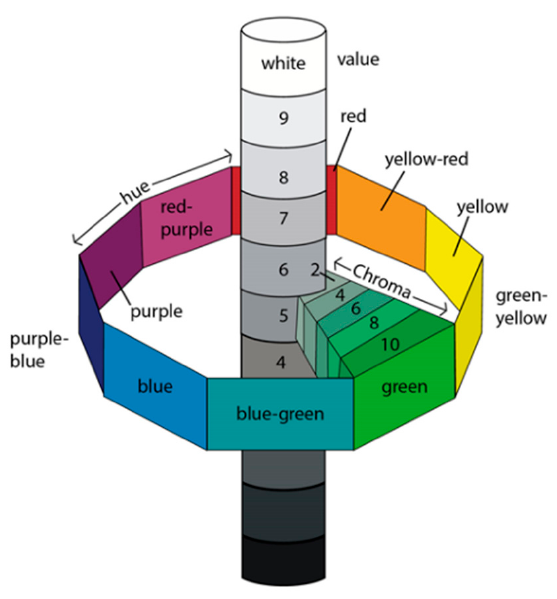
Figure 2. Munsell color system (adapted and re-drawn from ©1994 Encyclopedia Britannica, Inc., Chicago, IL, USA) .